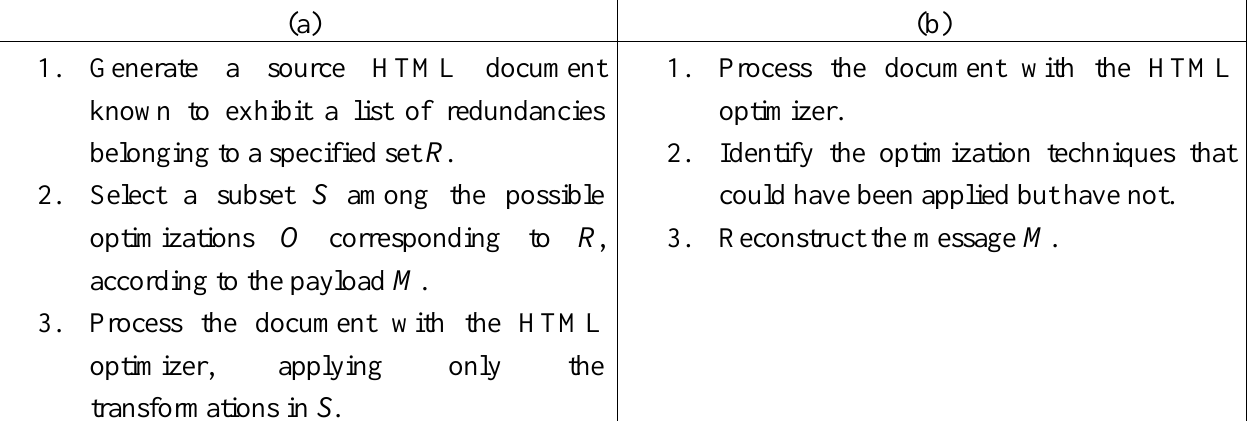
Figure 1. Basic algorithms for (a) encoding, and (b)